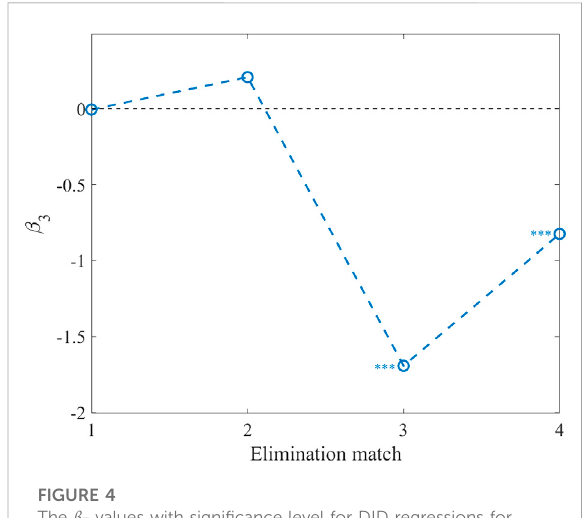
FIGURE 4 The β 3 values with signi fi cance level for DID regressions for sentiment